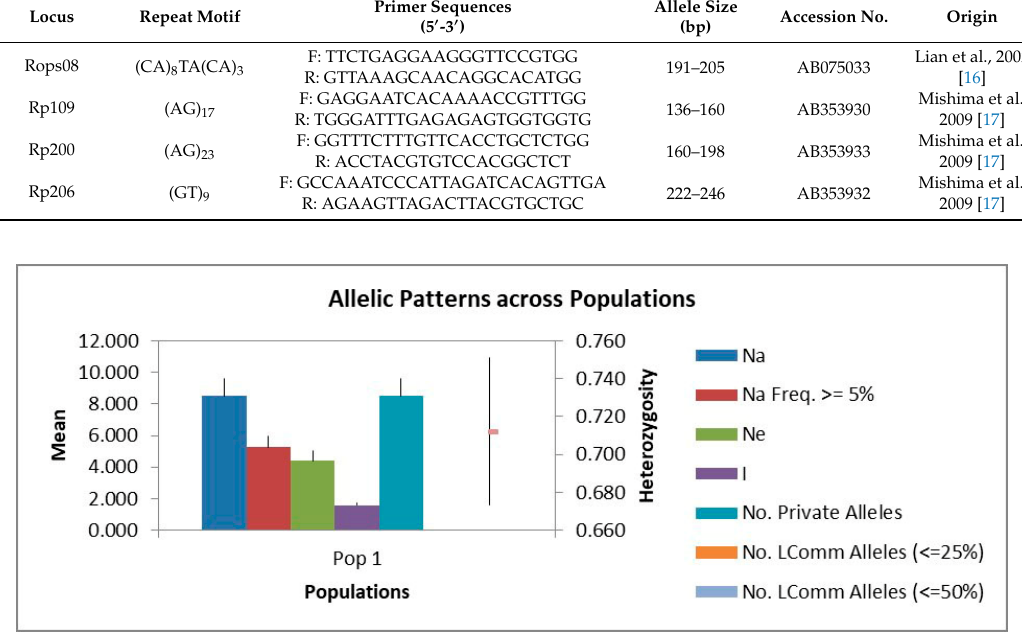
Table 3. Information on four published SSR markers.